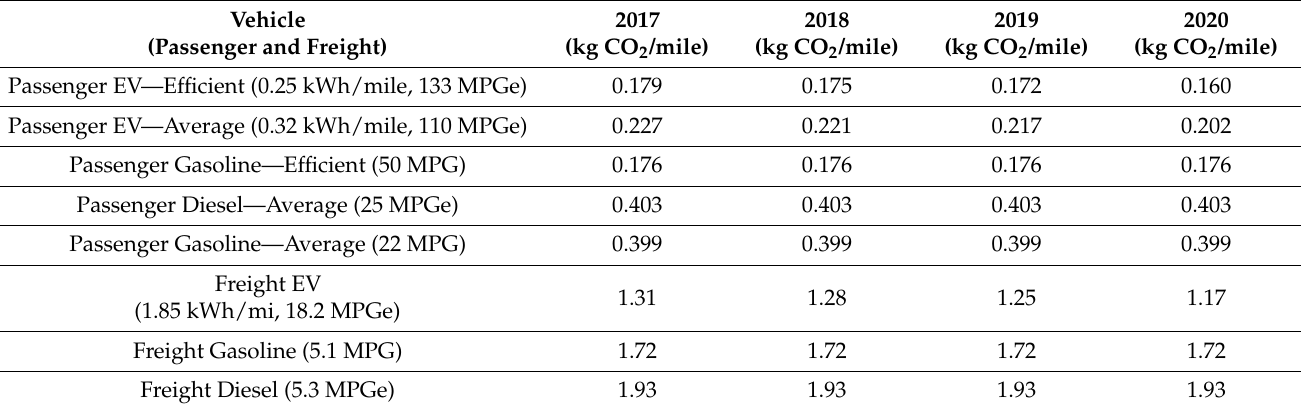
Table 2. CO 2 emissions per mile by vehicle and fuel type from 2017 through 2020 (kg CO 2 /mile).